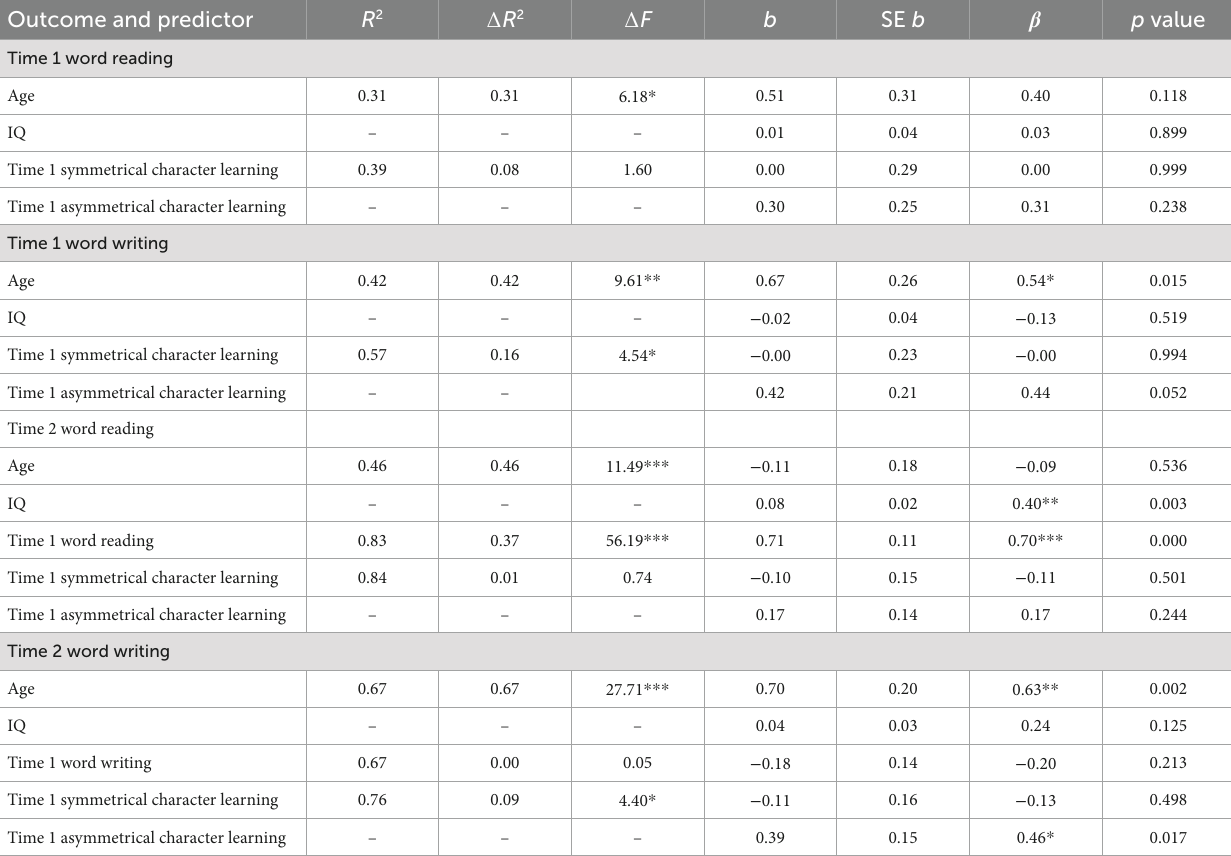
TABLE 3 Final model predicting Chinese word reading and Chinese word writing at Time 1 and Time 2 from character learning at Time 1. Outcome and